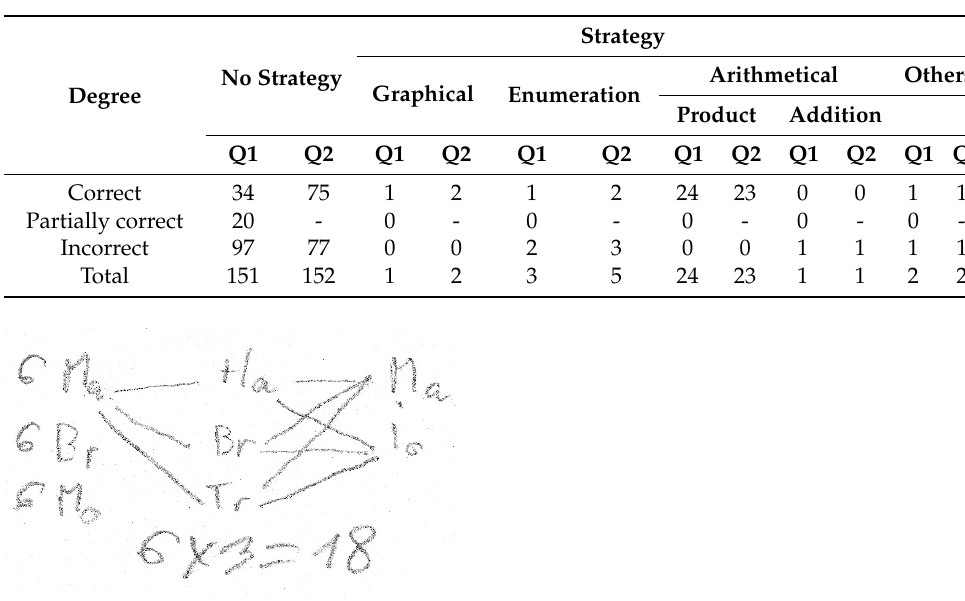
Table 3. Degree-strategy frequencies of Q1 and Q2.